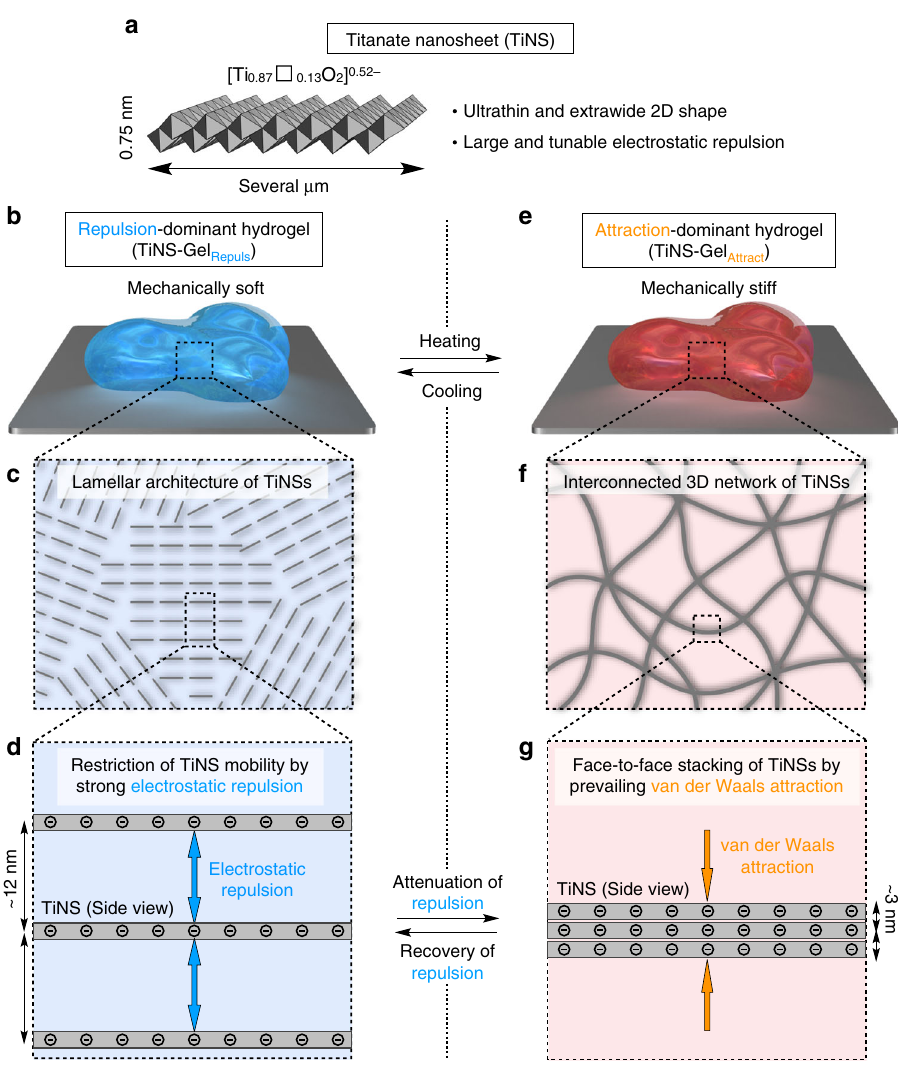
Fig. 1 Thermoresponsive hydrogel consisting of inorganic nanosheets (titanate nanosheet; TiNS) and water. a A schematic illustration of unilamellar titanate (IV) nanosheet (TiNS). Countercations are omitted for clarity. Open square indicates vacant sites. b – g Schematic illustrations of the hydrogel of TiNS (TiNS-Gel) in a repulsion-dominant state (TiNS-Gel Repuls ; b – d ) and an attraction-dominant state (TiNS-Gel Attract ; e – g ). When the